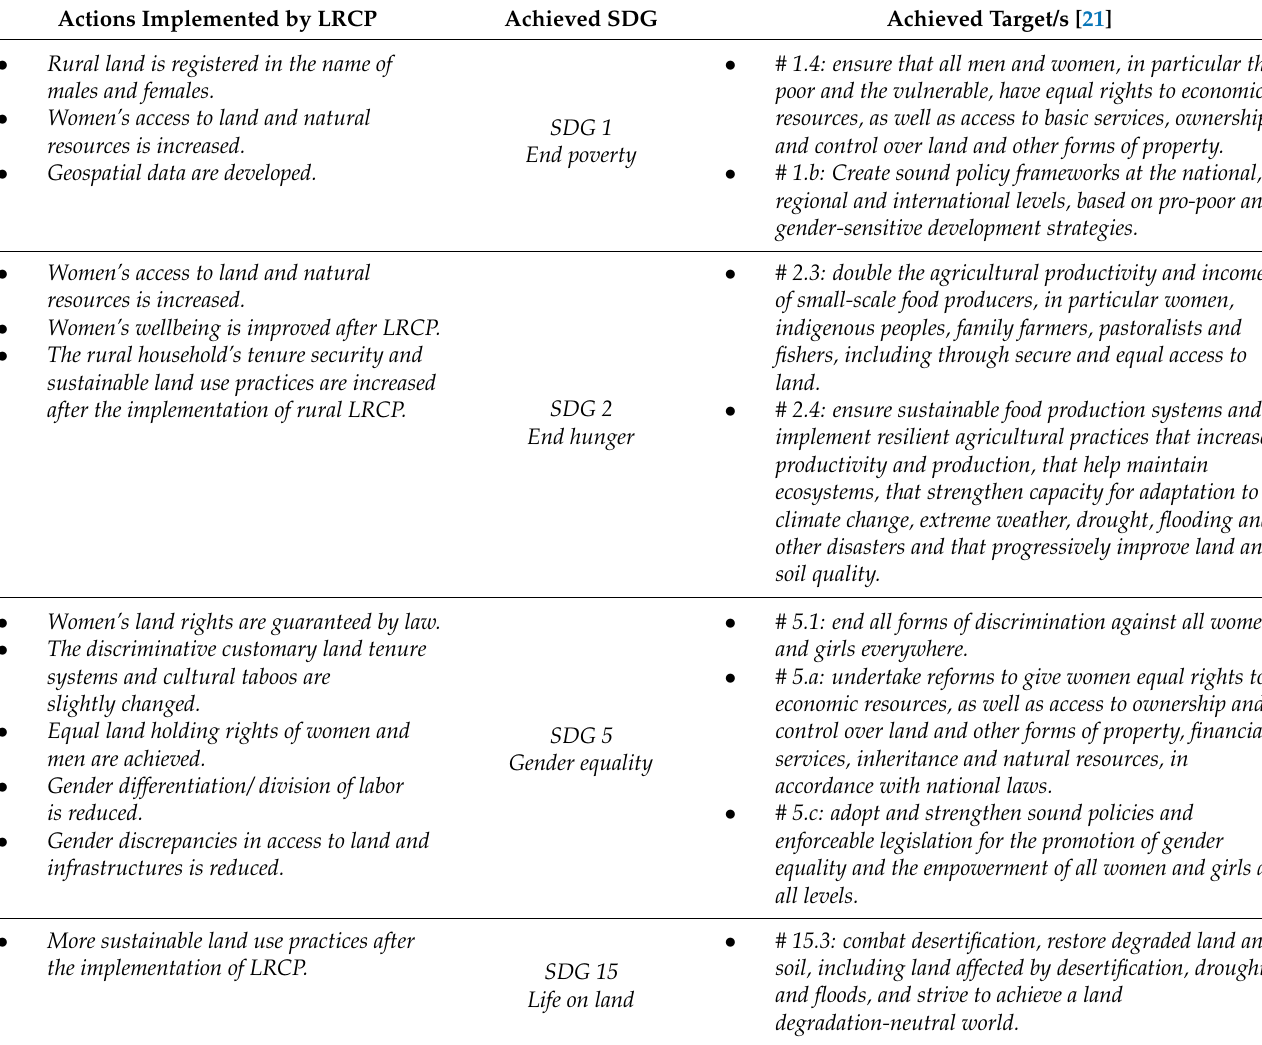
Table 2. The description of the achieved SDGs and targets by the implementation of the rural LRCP in the study